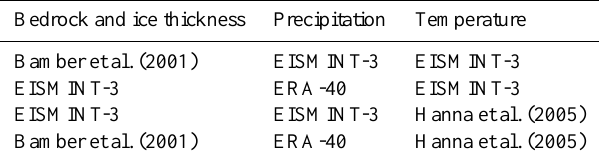
Table 2. Summary of sensitivity experiments performed by chang- ing each boundary condition/forcing individually from that used in the EISMINT-3 exercise to the more recent datasets. Also included is an experiment where all boundary conditions/forcings are up- dated together. For details on the EISMINT-3 datasets see Sect. 3.1.